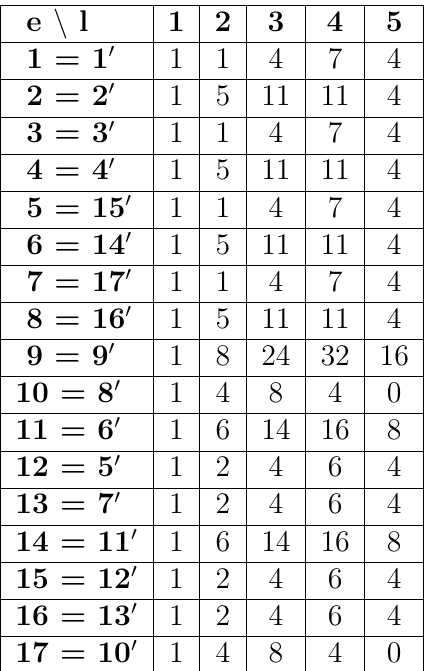
Table 4 : The edge path-table for trees 𝑇